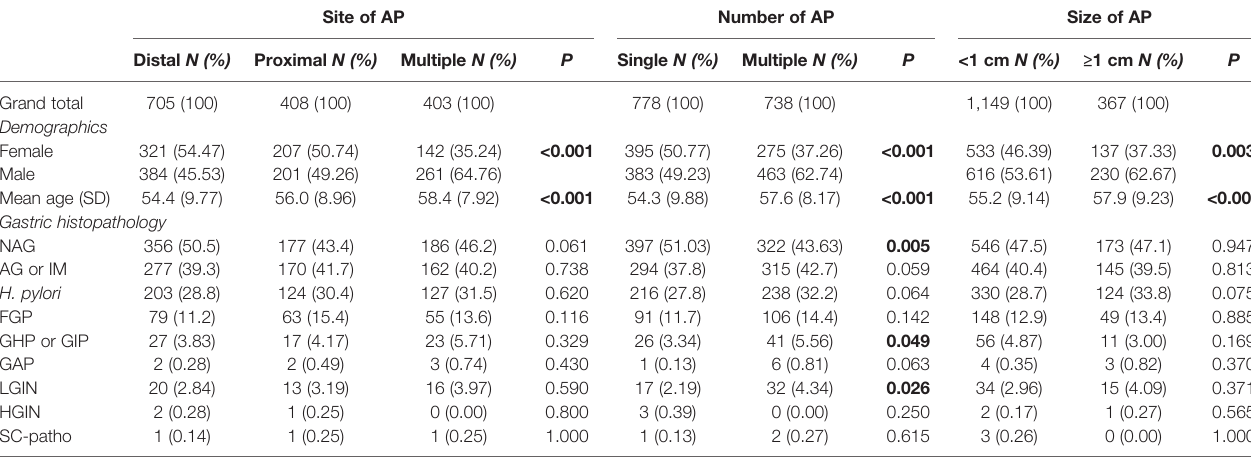
TABLE 2 | The Pearson c 2 test and t test were used to compare the association between various gastric histopathologies and the site, number, and size of AP. Site of AP Number of AP Size of